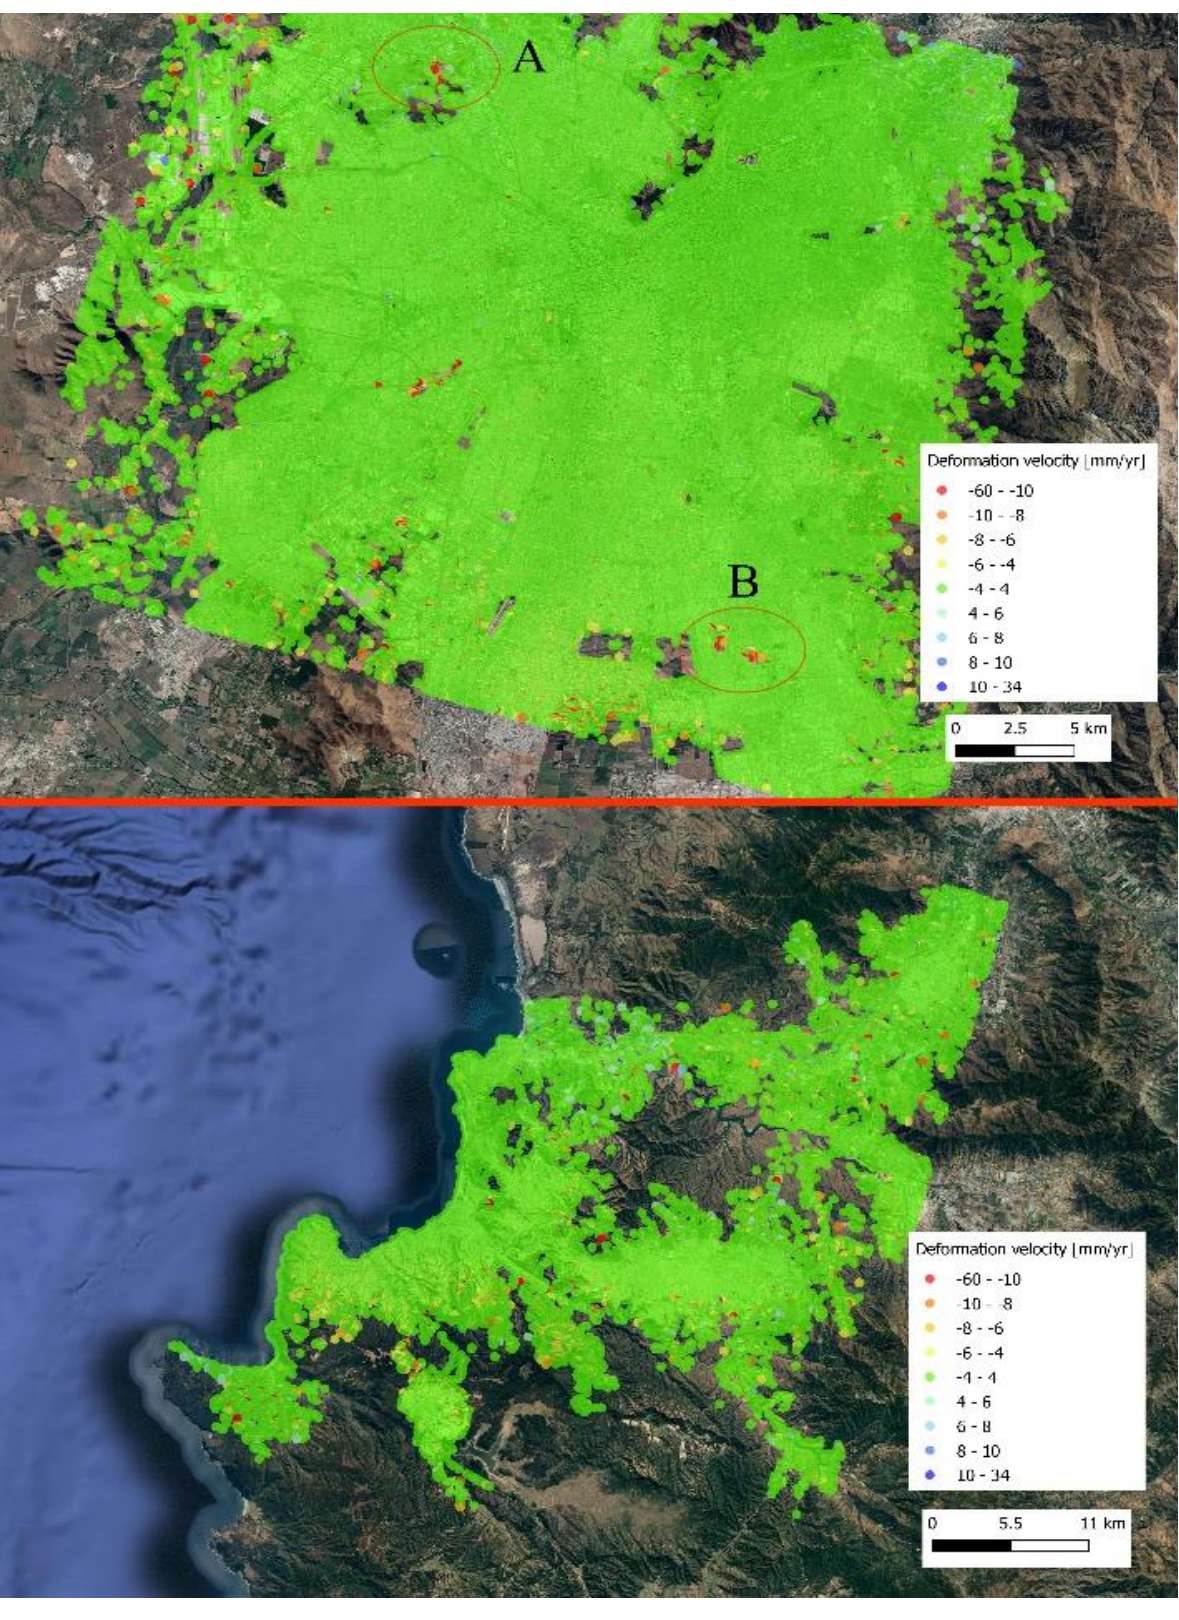
Figure 2. (up) Deformation velocity mape of Santiago (bottom) Deformation velocity mape of